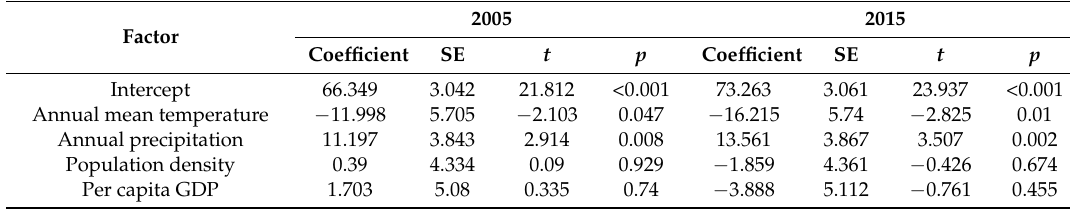
Table 4. Results of multiple general linear model regression for accessibility in 2005 and 2015. 2005 2015 Factor Coefficient SE